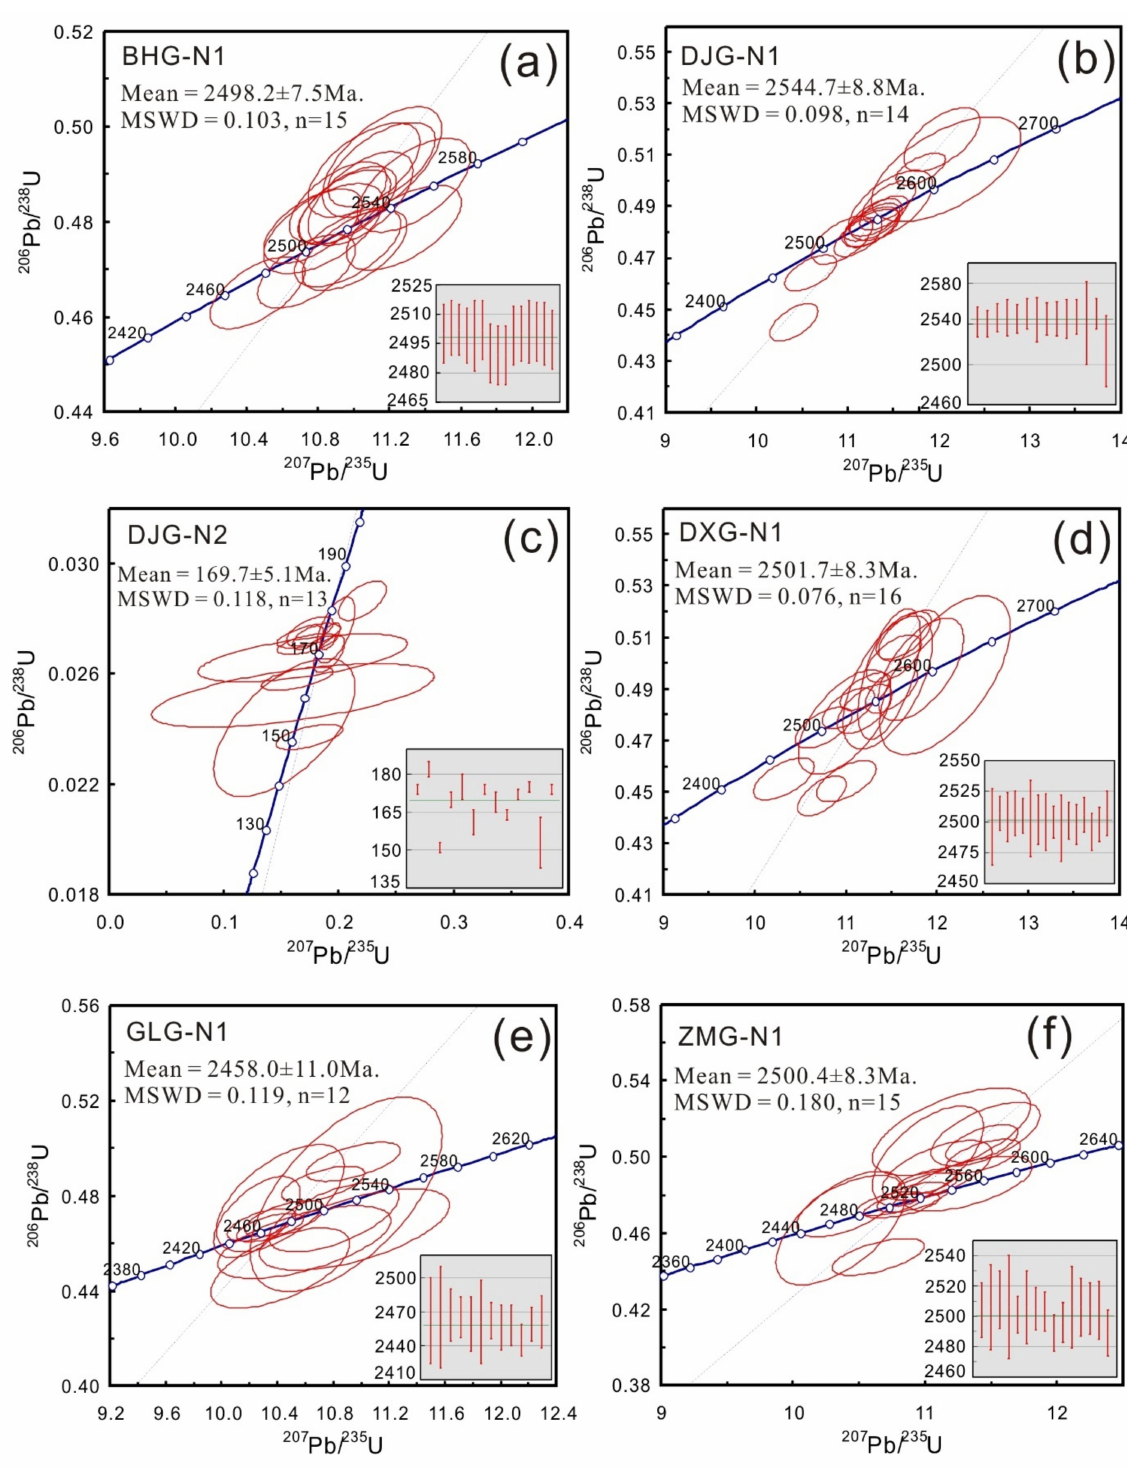
Figure 6. Concordant diagrams showing U–Pb data and mean age of zircons from the Liuhe orefield, NE